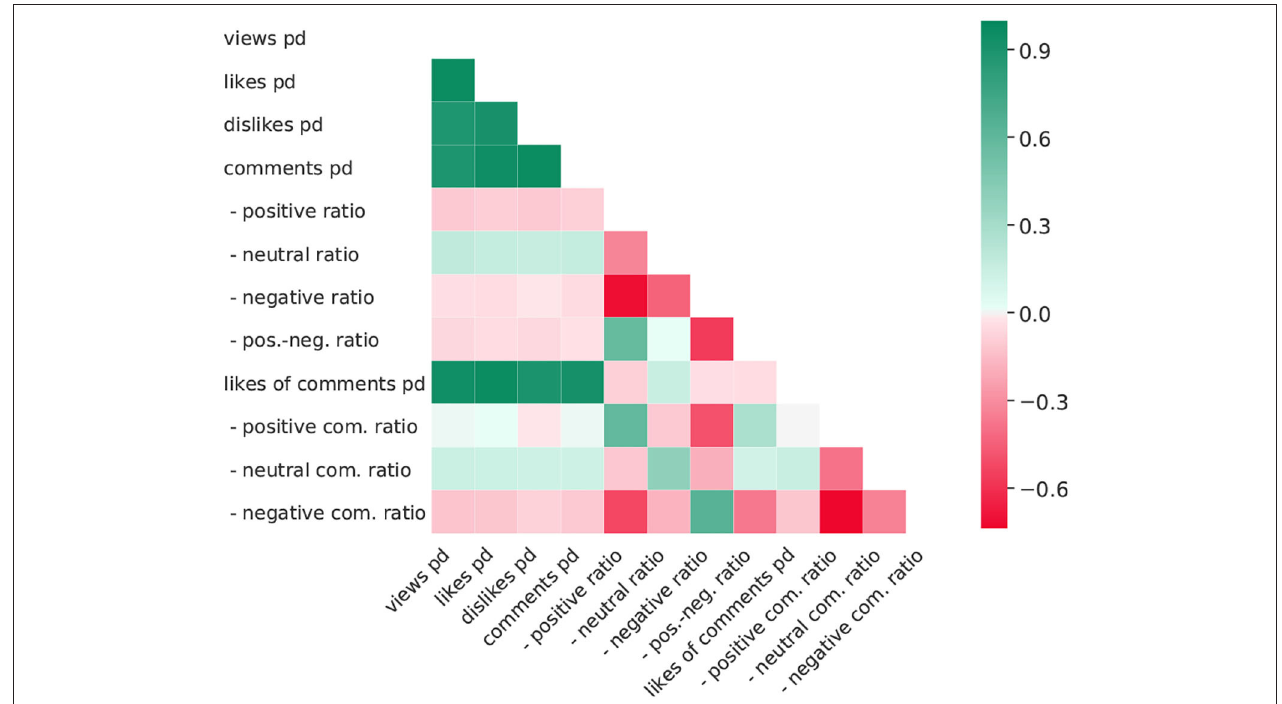
FIGURE 3 | Pearson correlation matrix of metadata. All results are considered to be significant at a 0.01 level. Com, comment; pos, positive; neg, negative; pd, per day.